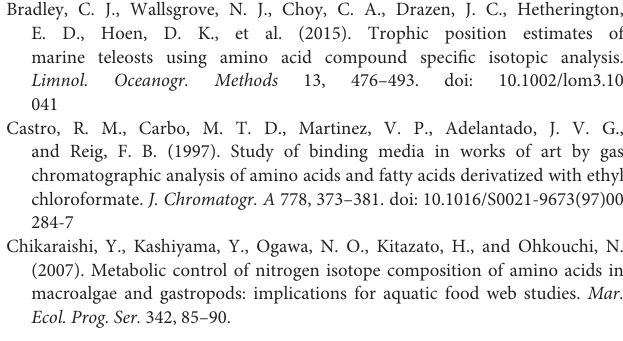
Supplementary Figure 1 | Amino acids standards calibration and chromatography. Typical results of derivatized vs. underivatized (elemental analyzer) amino acids standard isotopic values (A)- Chloroformate (Ezfaast), (B) - TFAA, (C) - NAP. Typical isotopic ratio mass spectrometry (IRMS) chromatogram of amino acids standard (D)- Chloroformate (Ezfaast), (E) - TFAA, (F) -